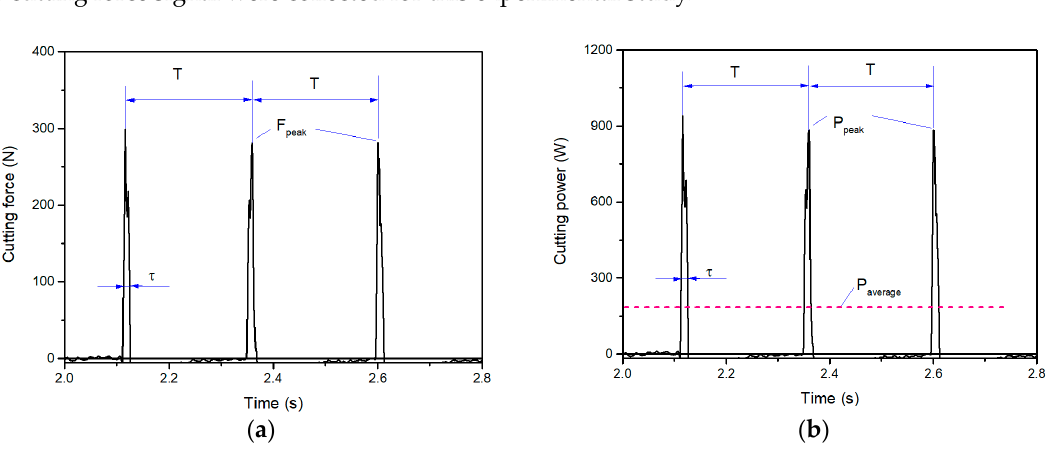
Figure 3. Example of experimental cutting force and power consumption signals.